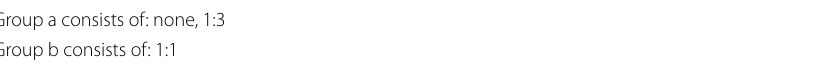
Table 44 HSD test groupings after ANOVA of AUPRC for the RUS factor